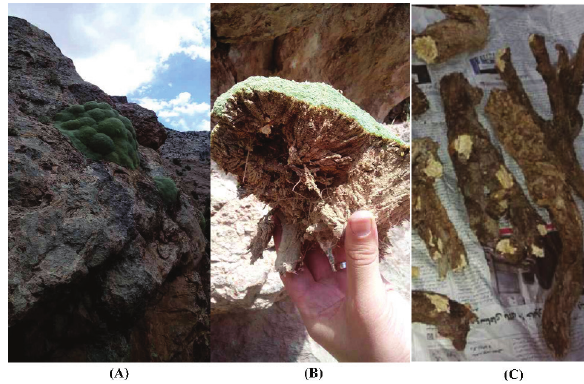
Figure 1: A display of Gypsophila aretioides : (a) habitat (b) aerial parts and (c) the